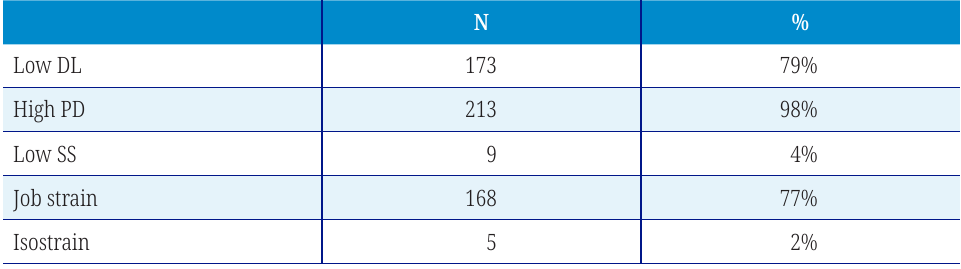
Table 3. Proportion of teachers exposed to the main stress factors at work